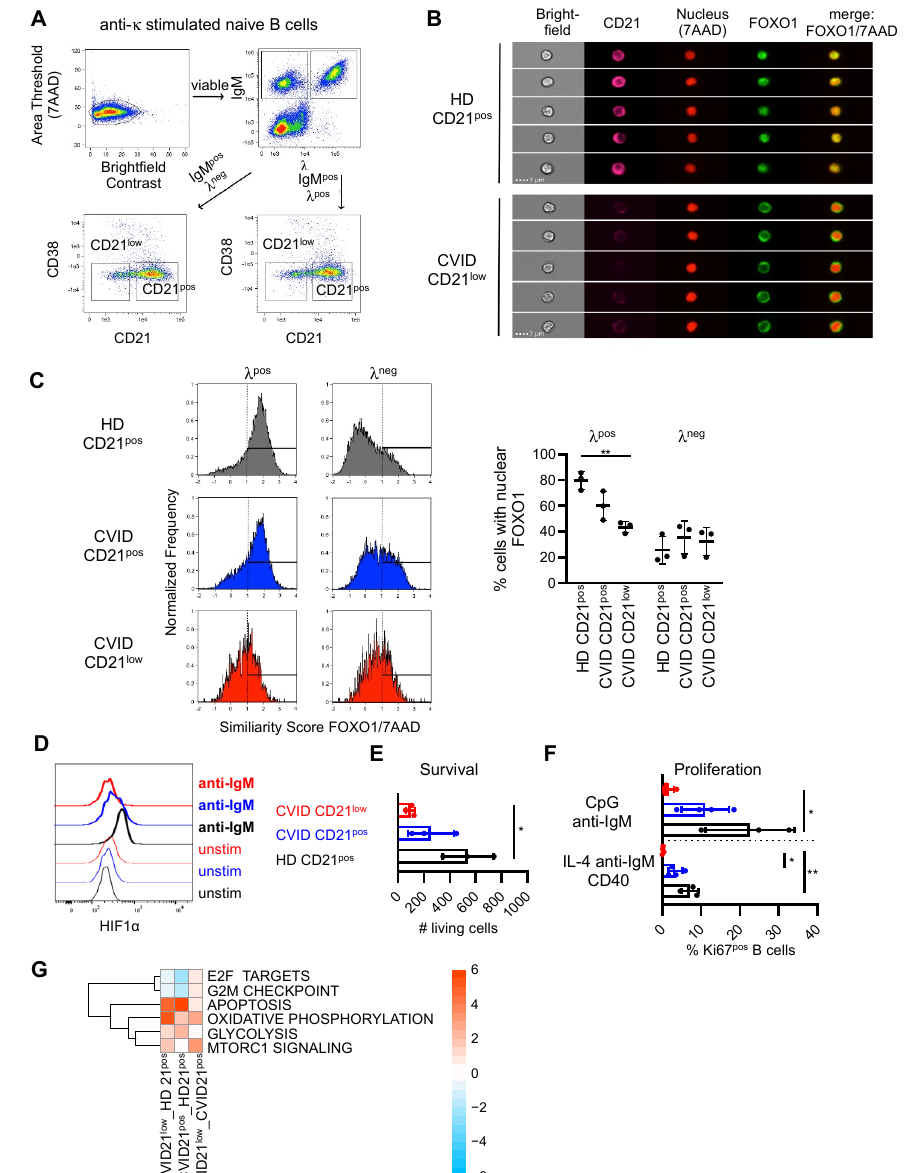
Figure 3. Disturbed signaling downstream of PI3K in CVID patients’ B cells. ( A ) Gating strategy for imaging and multicolor flow cytometry for nuclear FOXO1. Anti- κ -stimulated naïve B cells